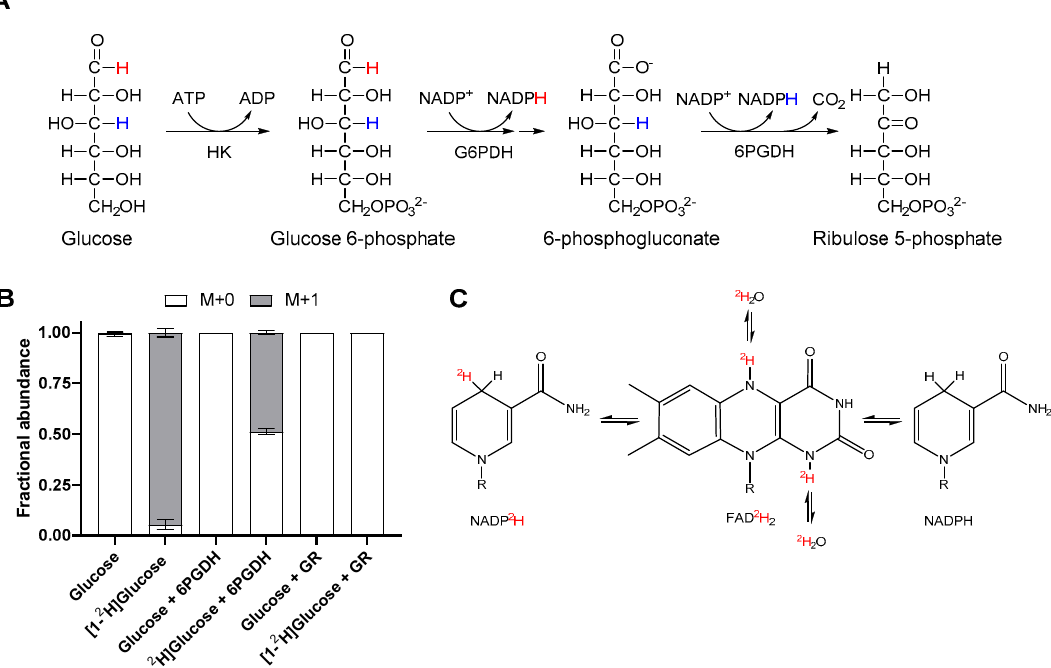
Figure 1. Validation of the labelling strategy for quantifying relative NADPH production via the oxPPP. ( A ) The route of deuterium incorporation from 1- (red) or 3- (blue) deuterated glucose into NADPH via glucose 6-phsophate dehydrogenase (G6PDH) or 6-phosphogluconate dehydrogenase (6PGDH). ( B ) Mass isotopologue distribution (MID) of NADPH after 4 h incubation with unlabelled or labelled substrate and in the presence or absence of glutathione reductase (GR) or 6PGDH. Samples were analysed using Zic-cHILIC chromatography and Xevo G2 XS MS. Values are the mean ± SD n = 3. ( C ) The route of hydrogen transfer between NADPH, FADH 2 and water catalysed by flavin enzymes.